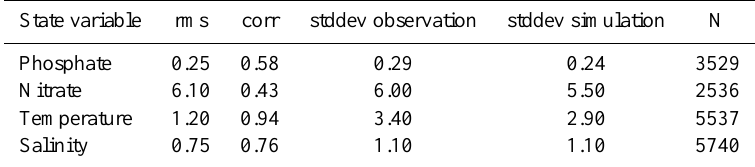
Table 4. Statistics for a quantitative comparison of simulated and observed state variables derived from Taylor diagrams (Taylor, 2001). rms is root mean squared, corr is Pearson’s correlation, stddev is standard deviation, N is number of observations. The statistics have been derived from all 155 boxes shown in Fig. 5. See text for details about data set and data